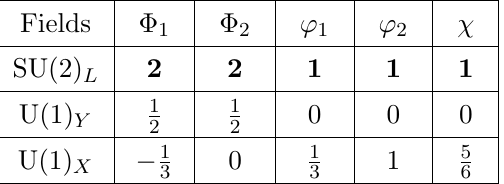
Figure 1 . The contours showing Z 0 contribution to (cid:1) C (cid:22) where yellow (light-yellow) region corresponds to 1 (cid:27) (2 (cid:27) ) region from global (cid:12)t in ref. [11].